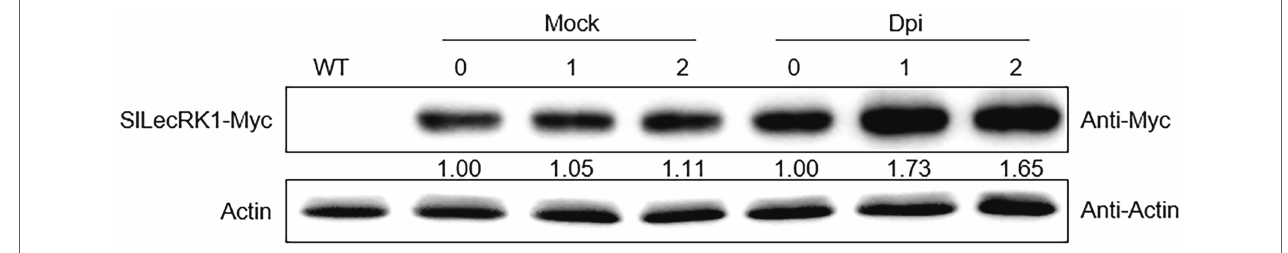
FIGURE 4 | SlLecRK1 Accumulation Following Inoculation with FORL . Ten-day-old SlLecRK1-OE1 seedlings were inoculated (or not) with FORL for the indicated number of days, after which SlLecRK1 protein was detected using anti-cMyc antibodies. The signal intensity was quantified and normalized to that of actin. The values for the day 0 samples were set to 1.